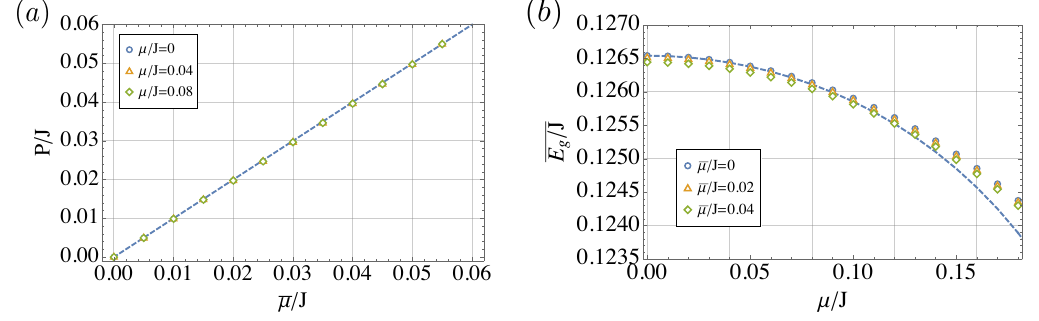
Figure 2 . A comparison between the numerics and (3.2) for (a). P (¯ µ ) with different µ/J , and (b). ¯ E g ( µ ) for different ¯ µ . In all cases we fix βJ = 120 and µ c /J = 0 . 05 . The dots are numerical data and the dashed line represents the prediction of (3.2). function G + ( τ ) ≡ | G ( τ ) | , and the numerical solution at 0 < β − τ < β/ 2 with the zero- αβ αβ temperature Green’s function G − ( τ ) ≡ | G ( τ − β ) | . For 1 /t 0 (cid:28) τ (cid:28) β/ 2 , the αβ αβ